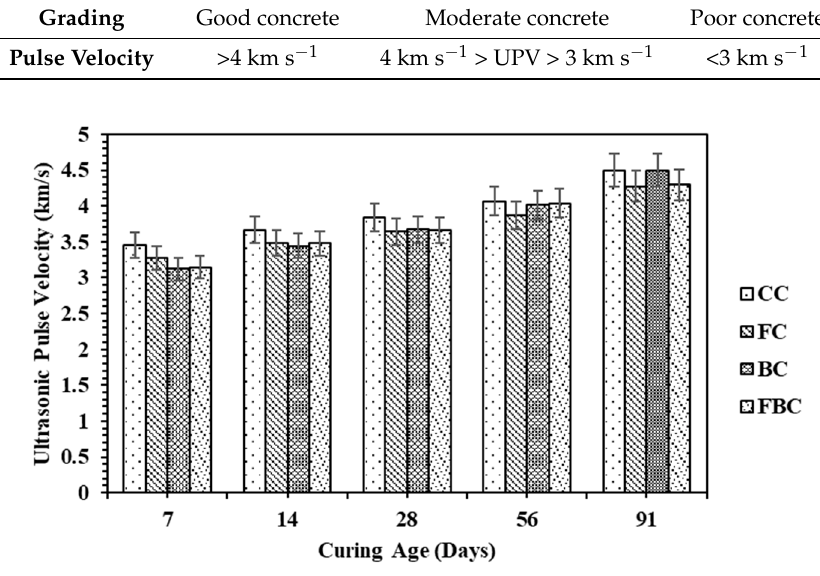
Figure 5. UPV values for concrete cylinders containing FA and BT.